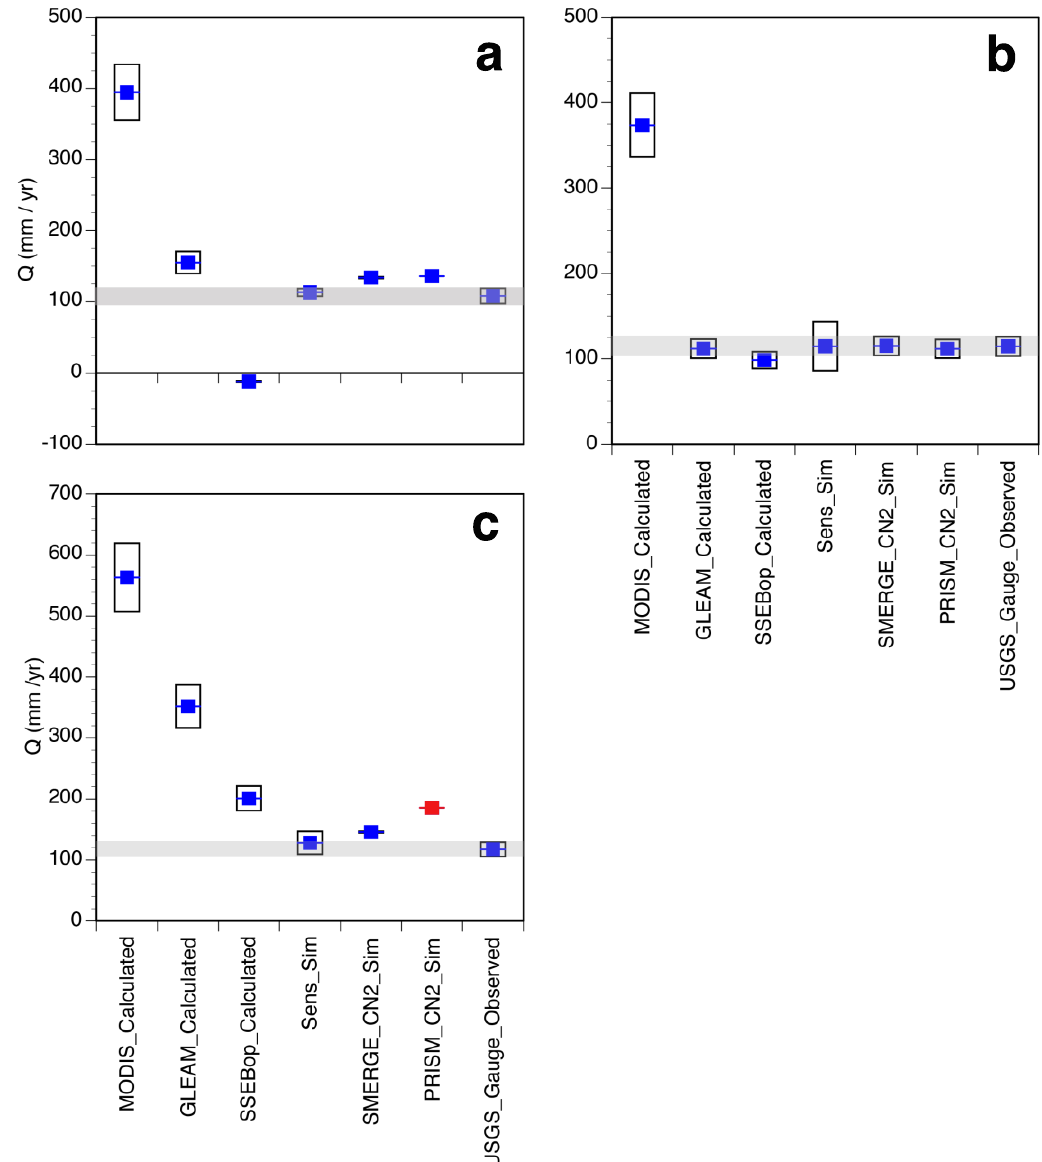
Figure 6. Same as Figure 5, except red symbol indicates an unacceptable simulation (RPS < 1.00). ( a ) CH-2016, ( b ) CH-2017, ( c ) CH-2018.